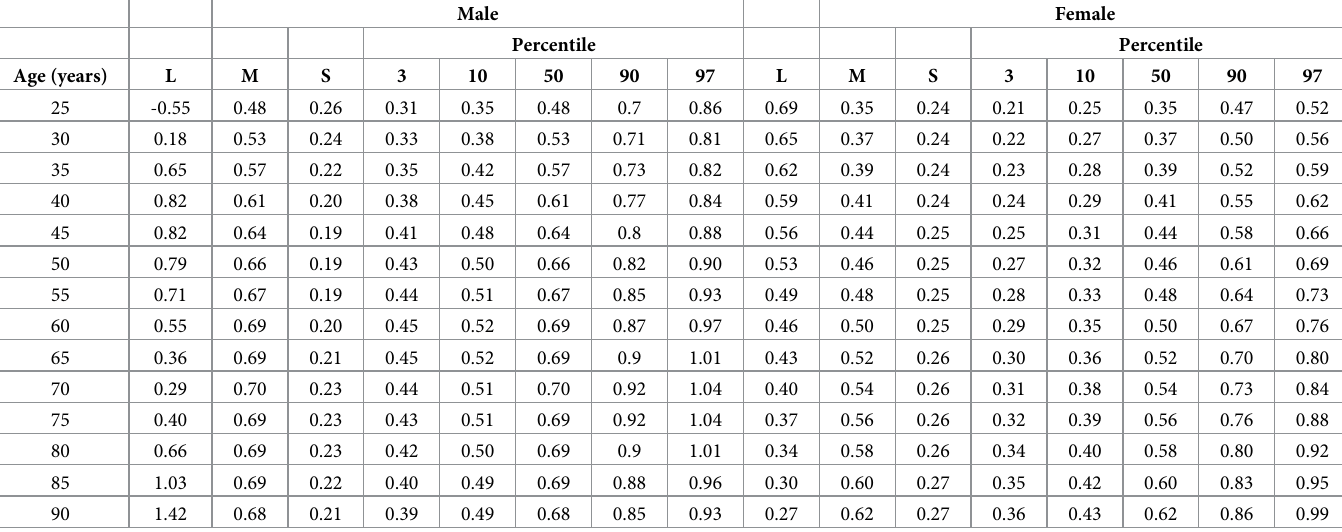
Table 5. Sex-specific percentile values for Android/Gynoid % fat ratio in individuals aged 21–90 years.